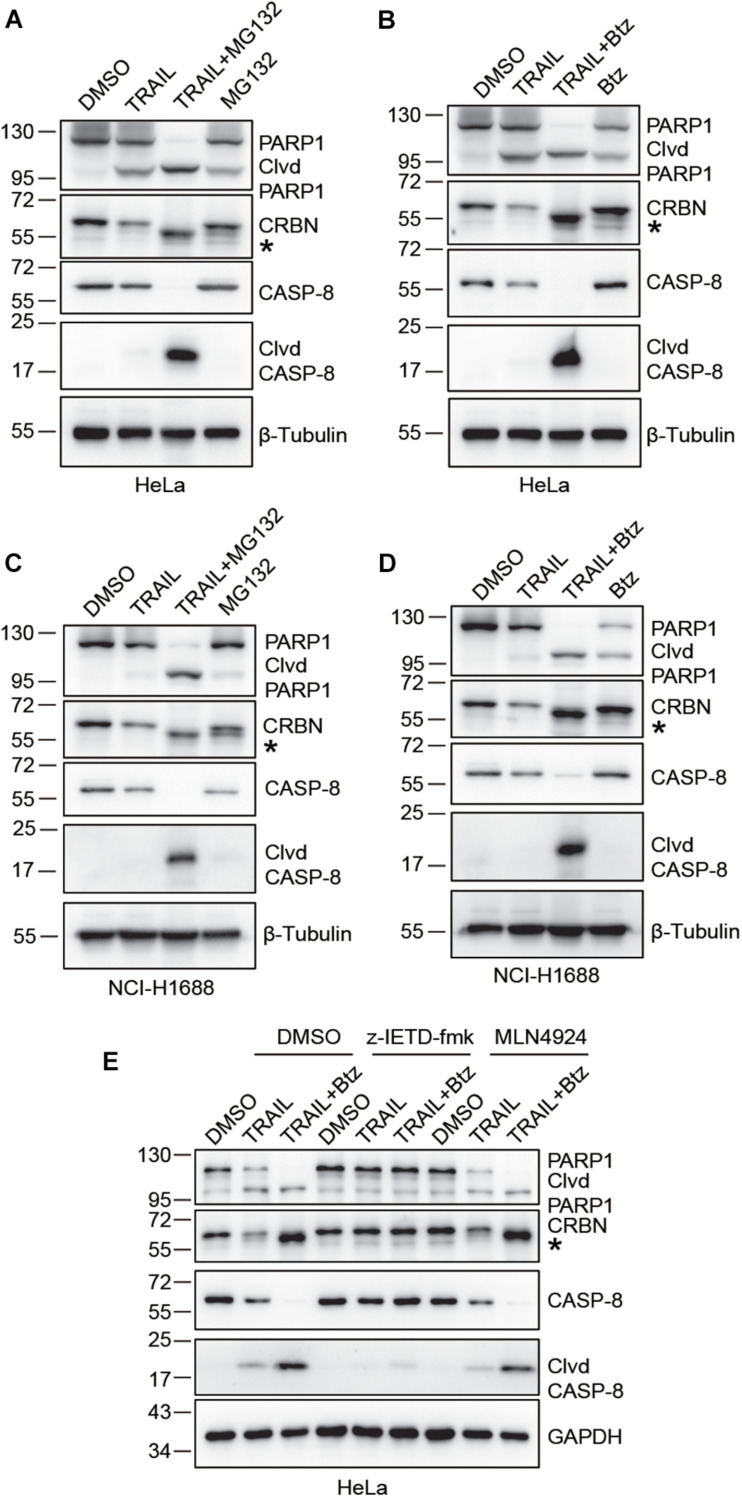
CRBN is cleaved upon co-treatment with TRAIL and proteasome inhibitors bortezomib (Btz) and MG132, and CASP-8 inhibition prevents the cleavage. (A–D) CRBN cleavage is detected when treated with TRAIL and MG132 or Btz. HeLa cells (A,B) or NCI-H1688 cells (C,D) were treated with DMSO, TRAIL (100 ng/ml), TRAIL (100 ng/ml) and MG132 (10 μM)/Btz (0.5 μM), or MG132/Btz for 24 h. (E) CASP-8 inhibitor (z-IETD-fmk) but not NEDD8-activating enzyme inhibitor (MLN4924) prevents CRBN cleavage. HeLa cells were pretreated with DMSO, z-IETD-fmk (40 μM), or MLN4924 (1 μM) for 30 min and then treated with DMSO, TRAIL (100 ng/ml), or TRAIL (100 ng/ml) and Btz (0.5 μM) for 24 h. After the treatment, cells were washed, harvested, and lysed, and the resulting cell lysates were subjected to immunoblotting analysis. Clvd, cleaved; *, cleaved CRBN.